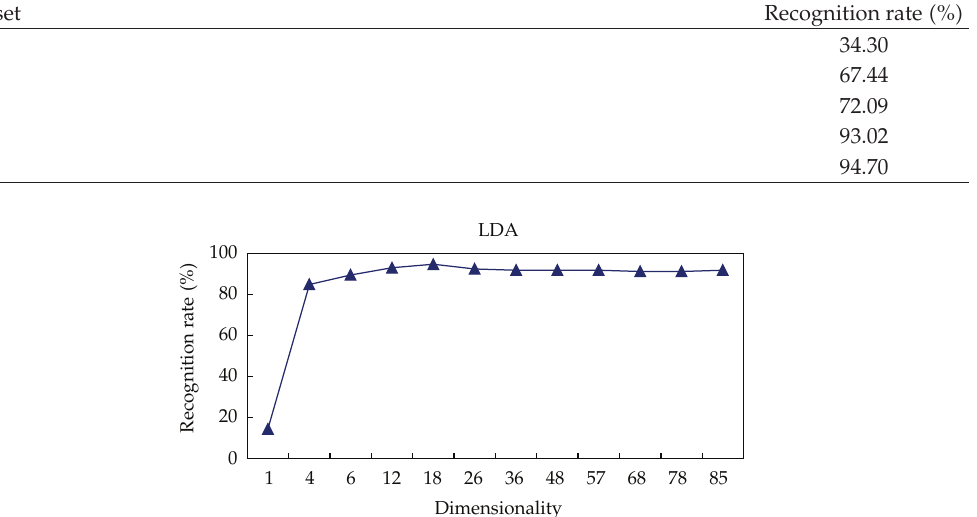
Figure 7: LDA recognition performance according to dimensionality via LDA algorithm with nearest neighbor